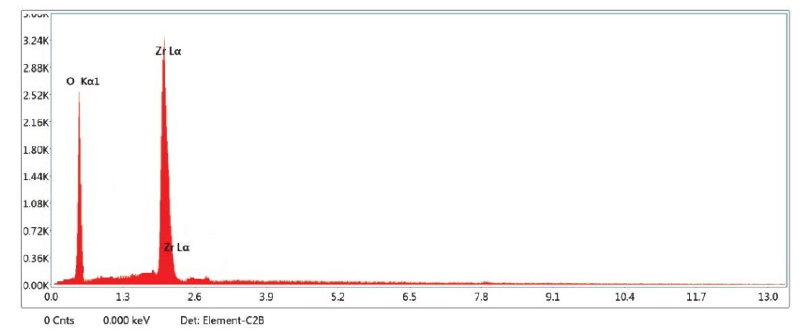
Fig. 3. EDX characterization spectra of